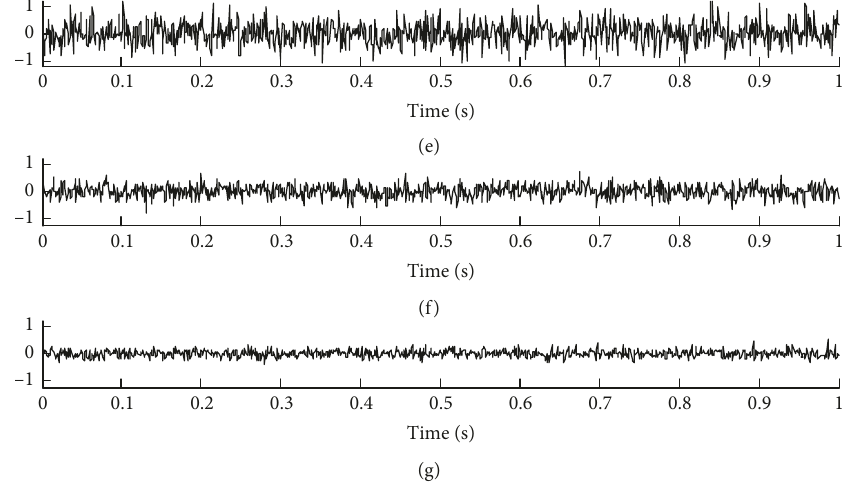
2 ( n ) in equation (12) and its components. (a), (b), and (c) the mixed signal x 2 ( n )